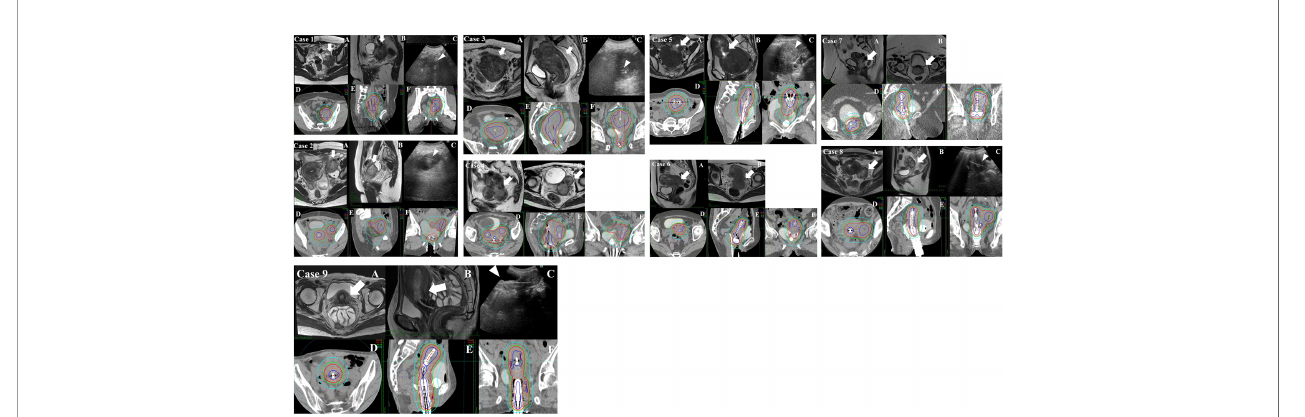
FIGURE 2 | Pre-brachytherapy MRI and brachytherapy dose distribution of cases 1 – 9. (A, B) The transverse and sagittal MRI images at the rectosigmoid junction taken within 1 week before the fi rst brachytherapy. (C) The view of transabdominal ultrasonography (TA-US) obtained during the brachytherapy (in cases 4, 6, and 7; TA-US images were unfortunately not saved in the medical record and are lacking). The thick white arrows indicate lymph node metastasis or massive uterine body tumor. The white arrowheads indicate interstitial needles within the tumor. (D – F) The brachytherapy dose distribution. The blue, orange, red, green, and sky-blue isodose lines represent 200%, 150%, 100%, 80%, and 50% of the prescription dose (6 Gy), respectively. Case 1 : A 34-year-old female patient underwent robotic-assisted hysterectomy with right salpingo-oophorectomy and pelvic lymph node dissection in another hospital for cervical squamous cell carcinoma pT1bN1M0 stage 3B according to the 2017 Union for International Cancer Control (UICC) 8th edition classi fi cation system. She experienced massive left internal iliac lymph node metastasis. The internal iliac lymph node metastasis was too deep to be visualized by transrectal ultrasonography (TRUS), so TA-US was used for needle insertion guidance. The volumetrically calculated CTV HR and the linear distance from the vaginal entrance to the deepest part of the target tumor at the fi